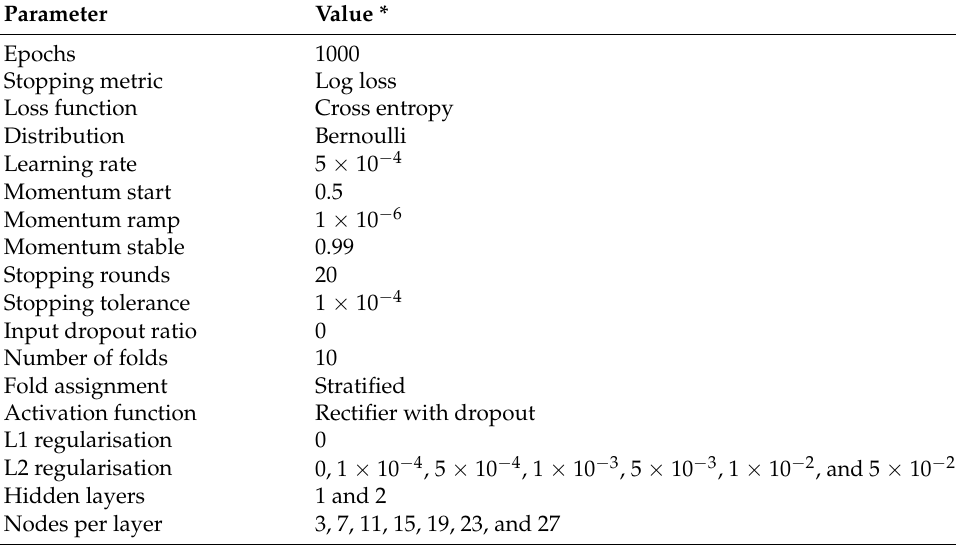
Table 3. Crucial parameters of the neural network algorithm, definitions, and values adopted.